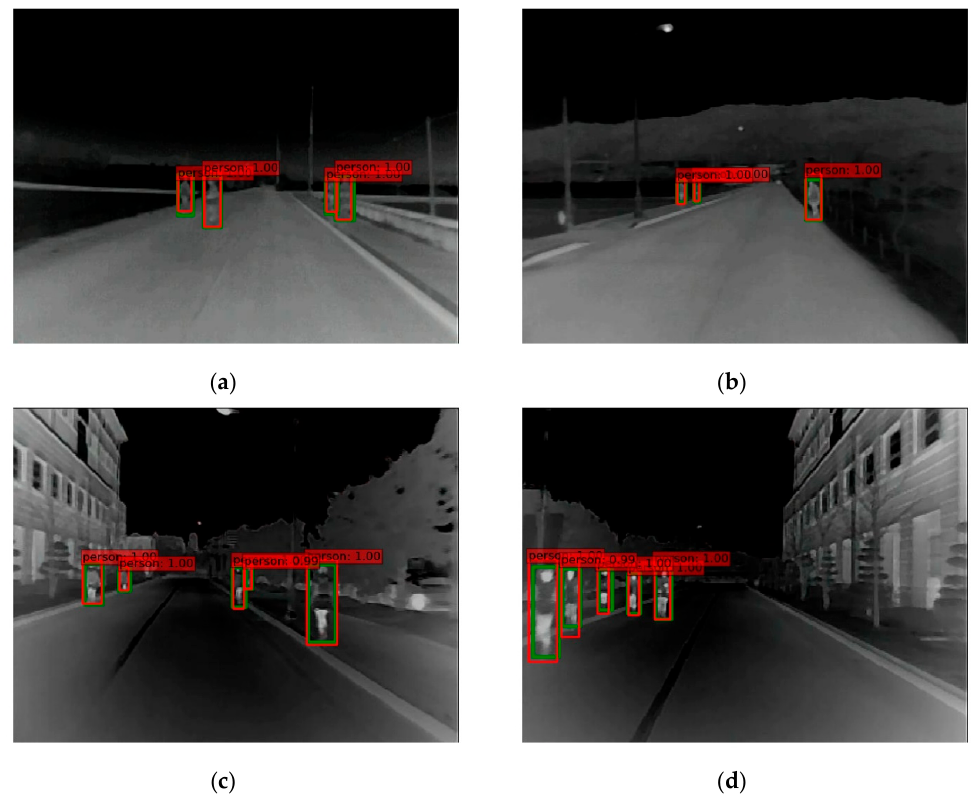
Figure 6. Some detection results on the KMU test dataset. The green bounding boxes denote the ground truth, and the red bounding boxes show the detection results. ( a–d ) are visualization of detection results on the image set selected from the dataset.